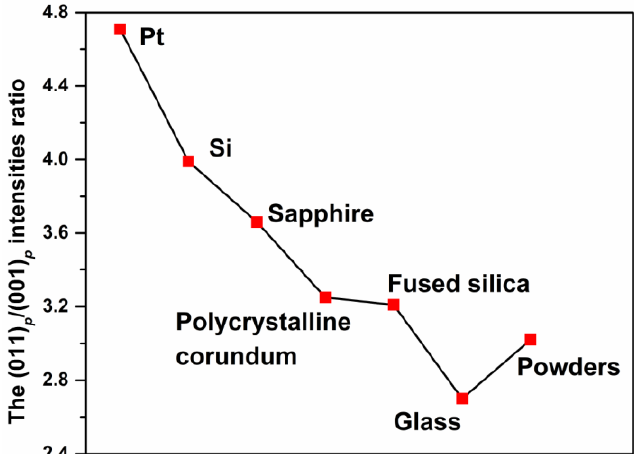
Figure 6. Ratio of the intensities of the (011) p and (001) p reflections in XRD patterns of the BLFSO films fabricated on different substrates. The point corresponding to the respective value for the powder sample is shown for comparison.